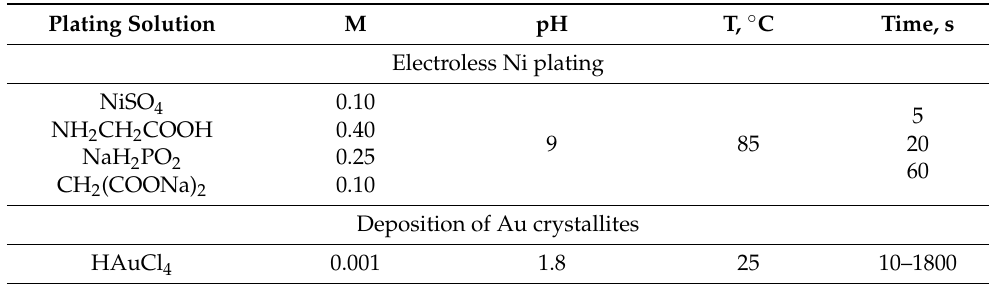
Table 1. Conditions of Ni-TiO 2 ntb and AuNi-TiO 2 ntb catalysts